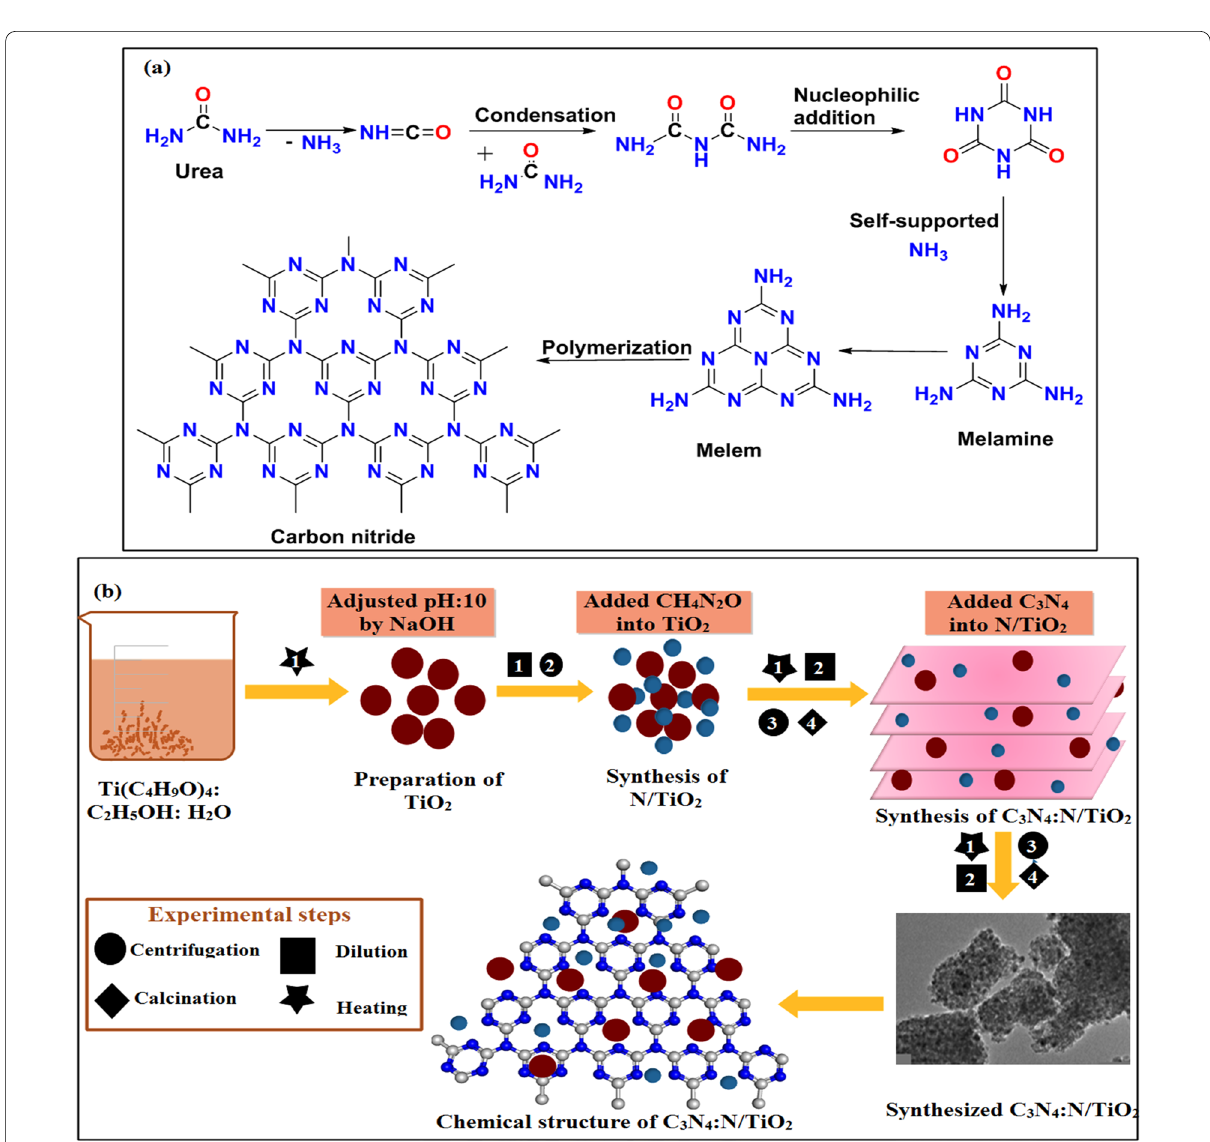
Fig. 1 a Synthesis mechanism of C 3 N 4 . b Schematic illustration of synthesis process for C 3 N 4 :N/TiO